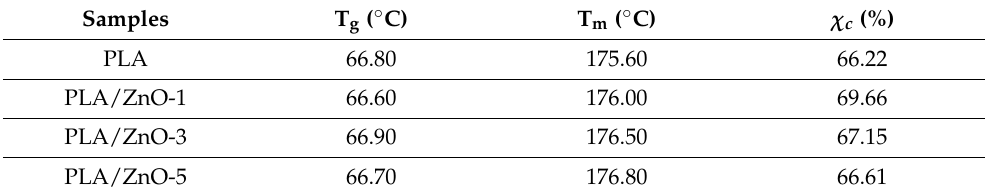
Figure 4. DSC thermograms of neat PLA and PLA/ZnO biocomposite filaments. Table 1. Thermal properties of 3D printing filaments from neat PLA and PLA composited with ZnO nanoflowers at varying